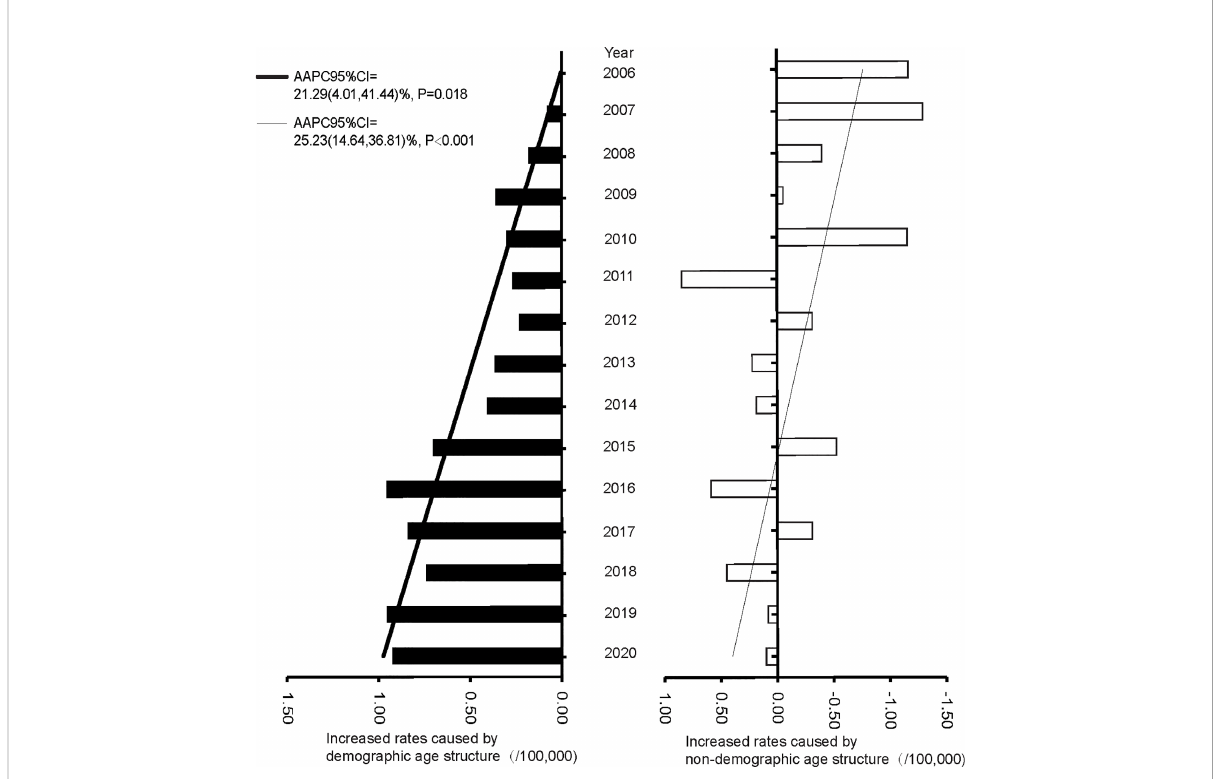
FIGURE 4 The increased rates caused by demographic and non-demographic factors from 2005 to 2020 in Pudong New Area, Shanghai,